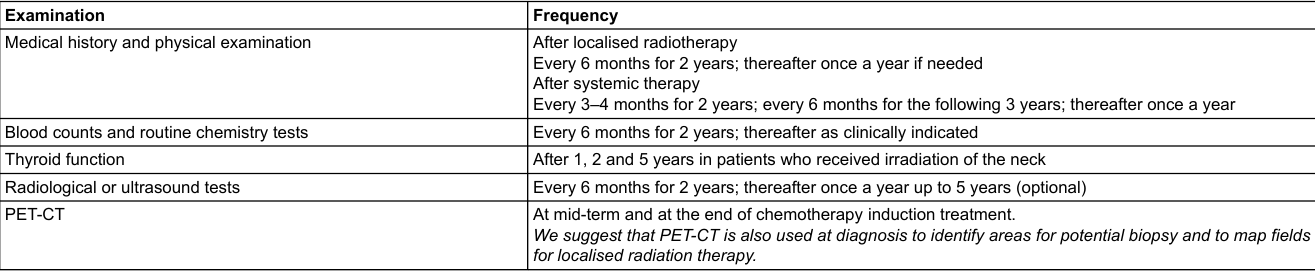
Table 3: Summary of the ESMO guidelines for the follow-up of patients with follicular lymphoma [5]. Examination Frequency Medical history and physical examination